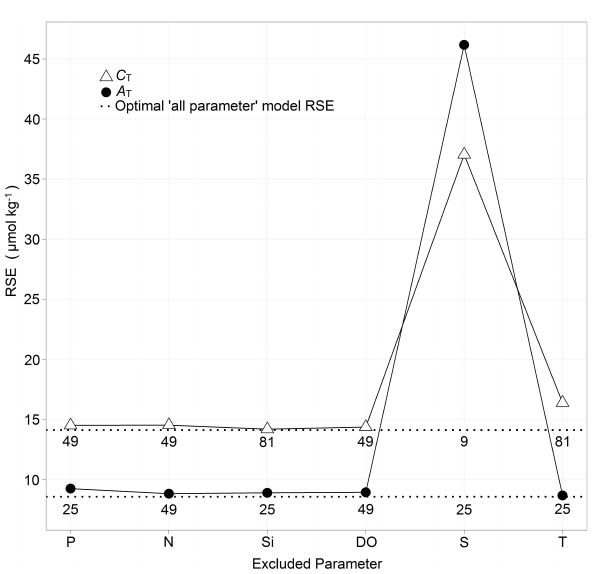
Fig. 6. RSE results for the C T (open triangles) and A T (black circles) SOMLO models when applied to the three independent datasets. Numbers under the dotted lines represents the optimal number of neurons to constrain the system. Excluded parameter rep- resents the variable not used in the SOMLO training and testing. Fig. 7. Optimal RSE values for (a) C